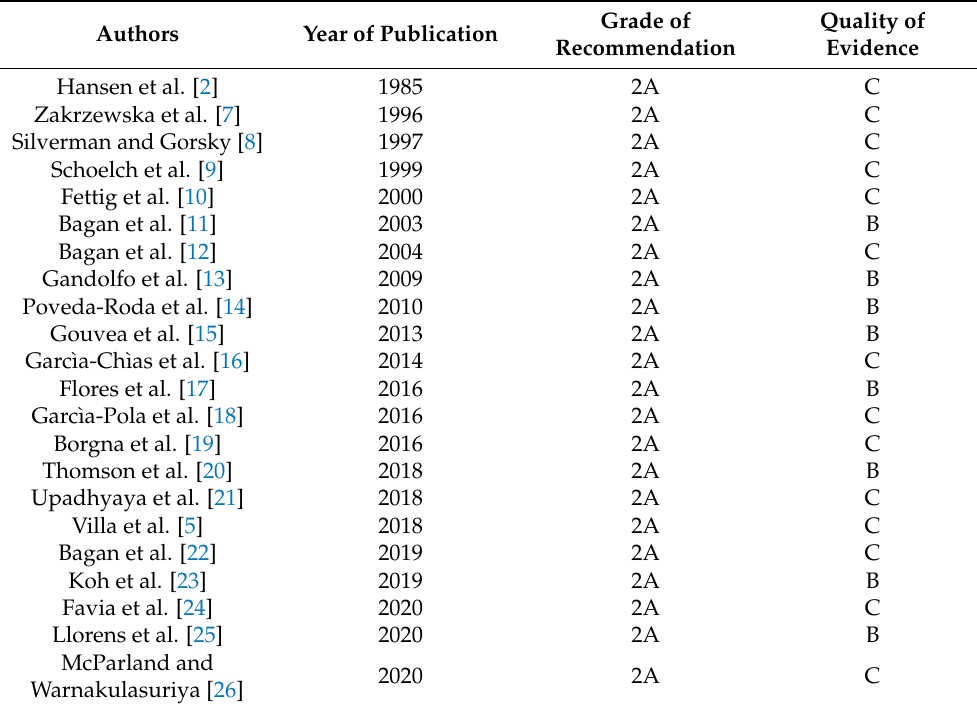
Table 2. Evaluation of recommendation and quality of evidence of included studies according to Robinson et al. [27]. (2A: weak recommendation; limited quality, patient-oriented evidence. B: Systematic review/meta-analysis of lower quality cohort studies with inconsistent results that may vary depending on circumstances or patients or societal values; retrospective cohort studies; case- control study. C: Consensus guidelines, usual practice, expert opinion, case series; other alternatives may be equally